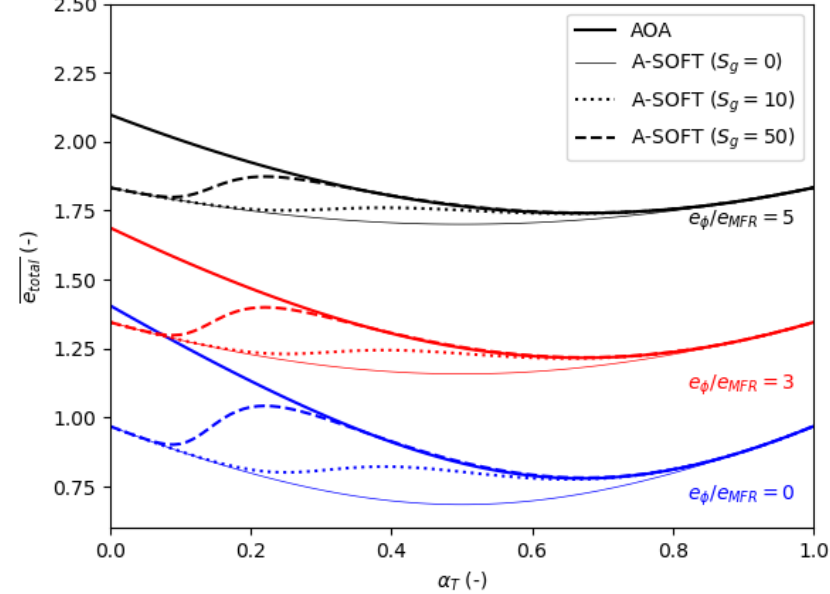
Figure A3. Normalized total error (fuel rich combustion).